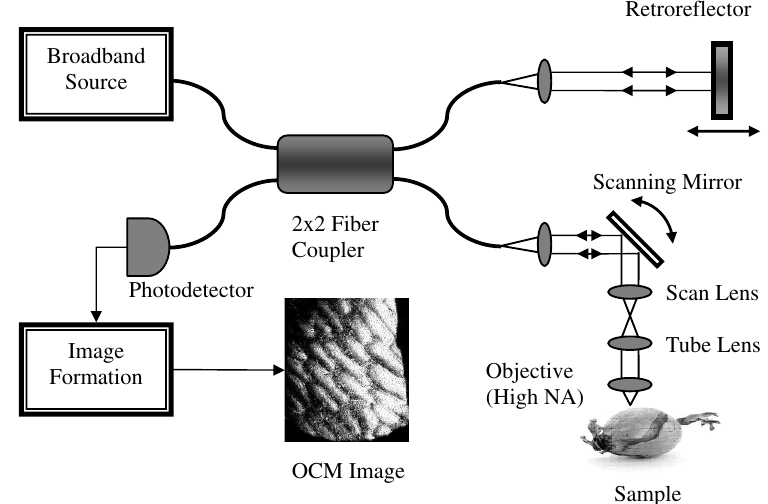
Fig. 4. A typical optical scheme of